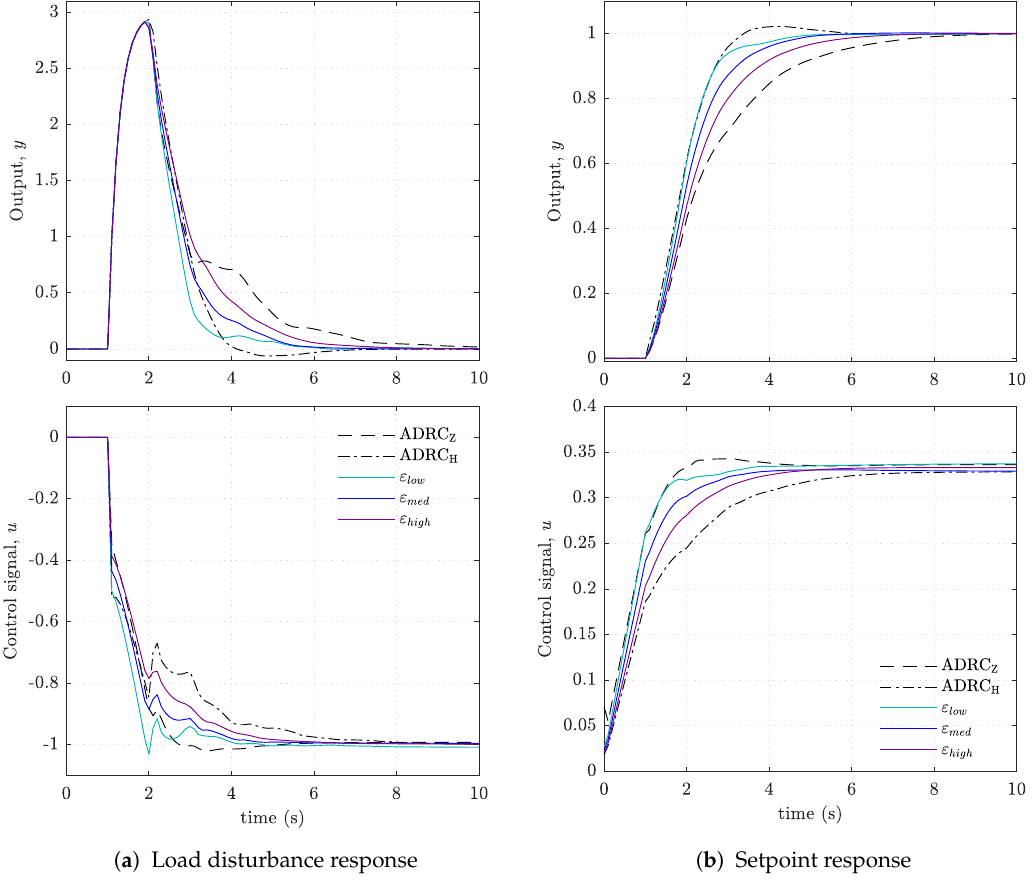
Figure 14. Closed loop time response of G 2 ( s ) with the second-order LADRC tuned with the proposed rules. Comparison with the performance of ADRC z and ADRC H